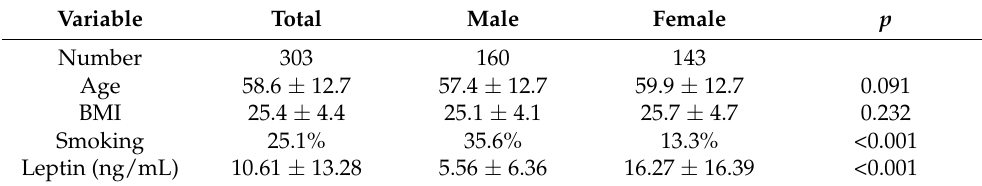
Table 1. Baseline characteristics of study subjects.